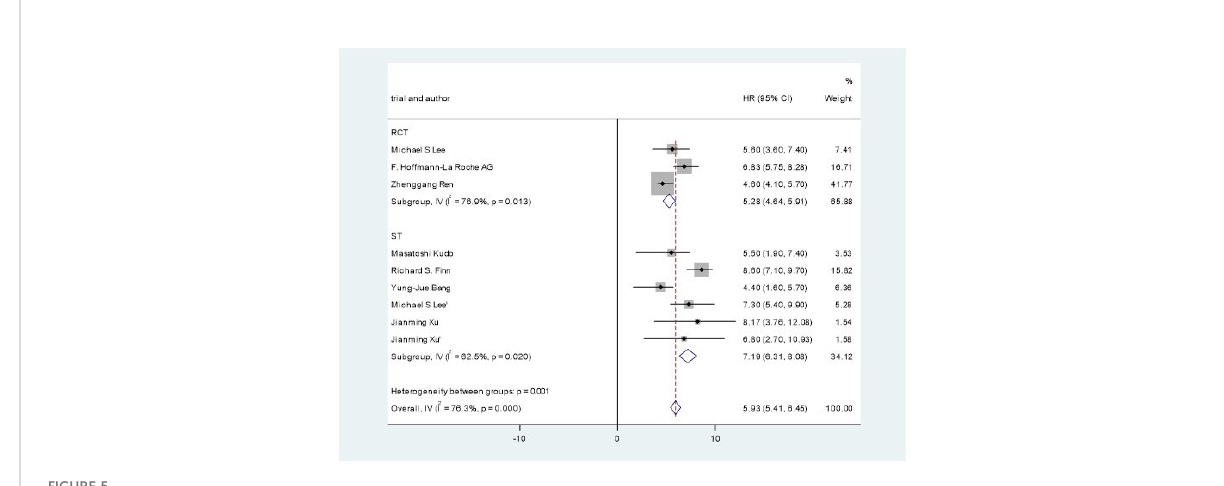
FIGURE 5 Pooled analysis of PFS in patients with HCC treated with immune checkpoint inhibitors combined with antiangiogenic drugs.